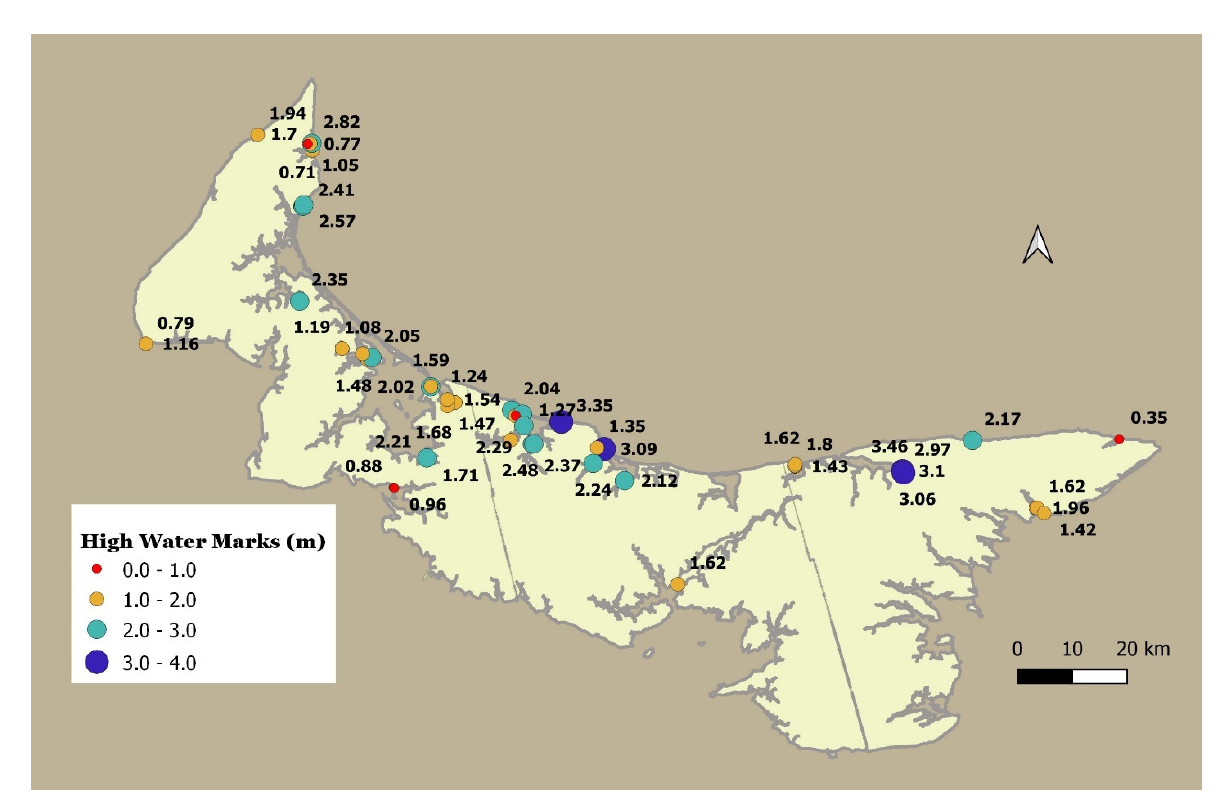
Figure 5. The measured HWMs in PEI after Dorian between 15 Sep and 25 Oct 2019.